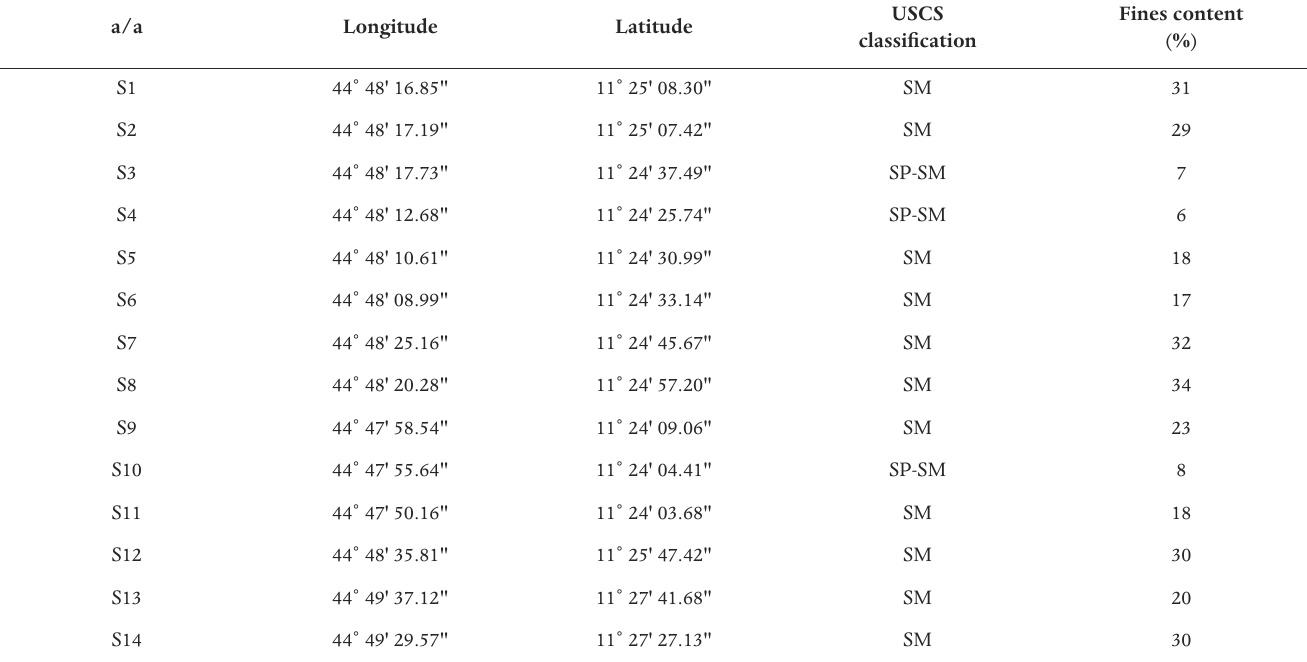
Table 1. Grain size characteristics of the collected